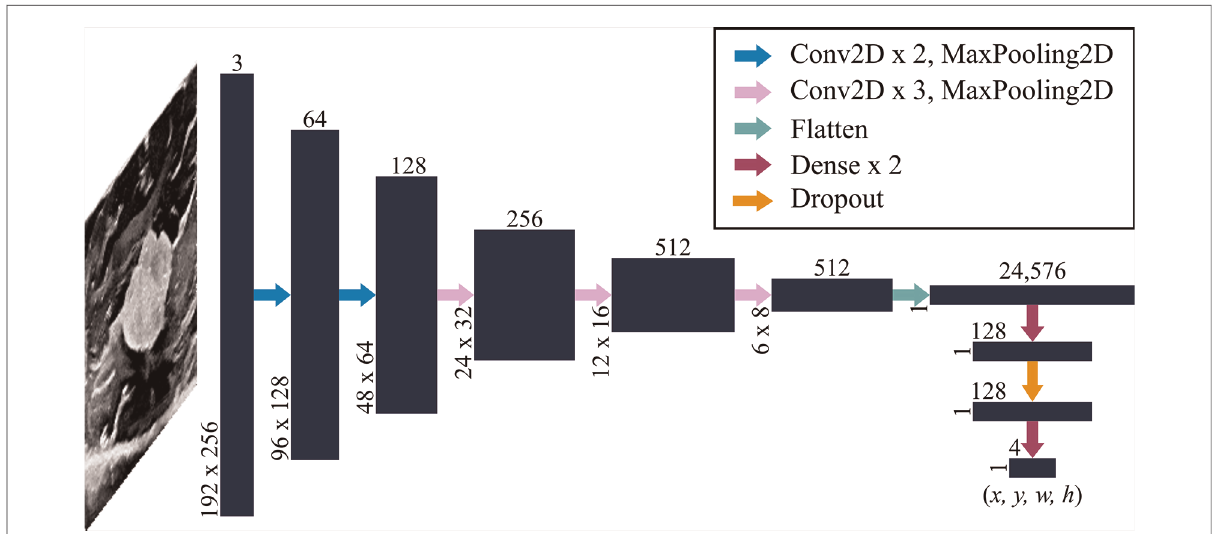
FIGURE 3 Network architecture. A convolutional neural network known as VGG16 was used as a backbone with an additional dense network split with a layer of dropout. Vertically and horizontally displayed number values indicate the 3-dimensional sizes of each layer (navy blue). The input is a 192 (cid:3) 256 (cid:3) 3 array (where the depth of 3 represents red, green and blue values assigned to each pixel) that is transformed to an output that is 1 (cid:3) 4. These 4 values represent the x and y coordinates of the upper left corner of the predicted bounding box as well as the width and height of the box. Each arrow represents a function applied to the preceding layer as indicated in the legend. Convolutional layers were implemented with a 3 (cid:3) 3 kernel size; max pooling layers used a 2 (cid:3) 2 stride size; and dropout was